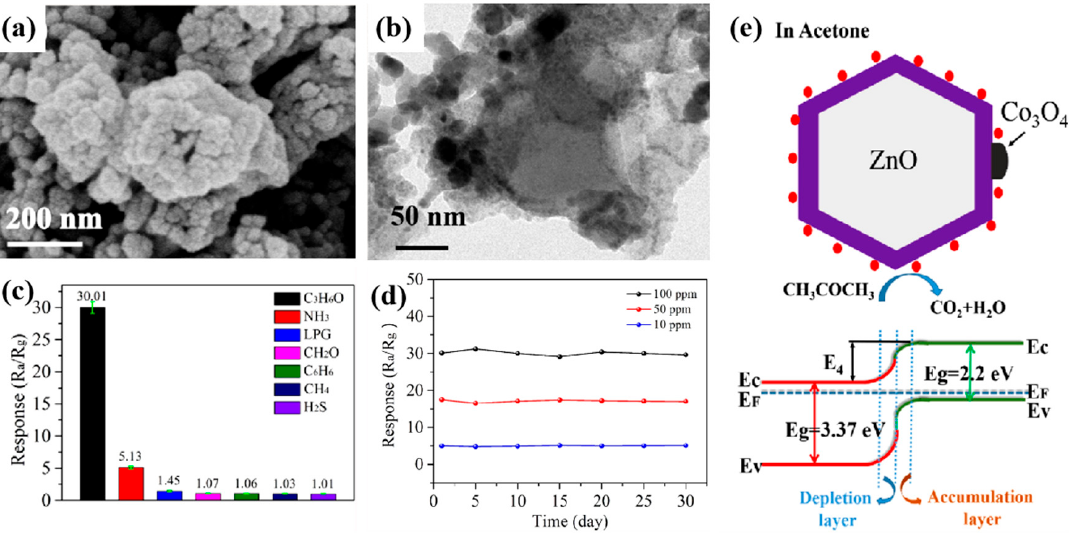
Figure 4. SEM ( a ) and TEM ( b ) images of the ZIF-8/ZIF-67-derived ZnO/Co 3 O 4 nanopolyhedrons; ( c ) Selectivity of the ZnO/Co 3 O 4 nanocomposite sensor; ( d ) Long-term stability over 30 days toward 10, 50, and 100 ppm acetone of the ZnO/Co 3 O 4 nanocomposite sensor; ( e ) Schematics of the acetone sensing mechanism of the ZnO–Co 3 O 4 heterojunction [74].